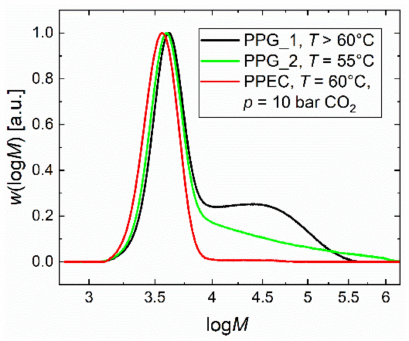
Figure 2. Molecular weight distributions (MWDs) of the polymers of the experiments depicted in Figure 1a–c (Entry 1–3). Table 1. Molecular weights M n and M w of polymers obtained from batch experiments of Figure 1a–d. Entry Polymer M n [kg / mol] M w [kg / mol] PDI 1 PPG_1